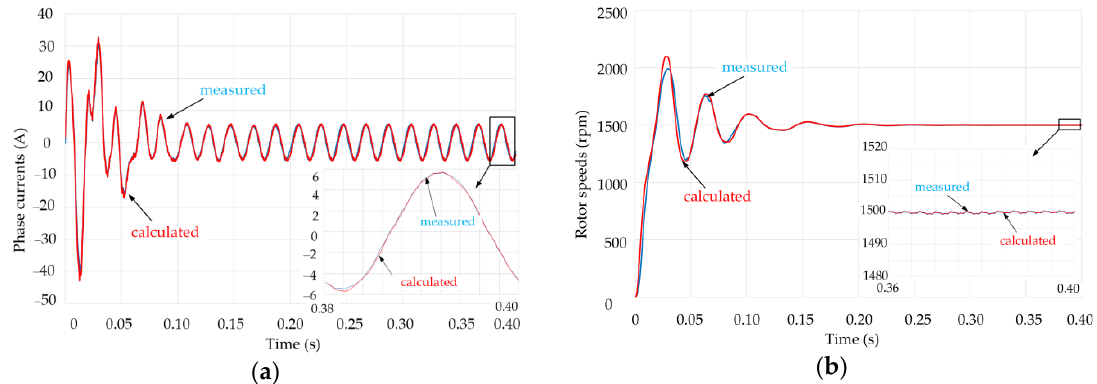
Figure 7. Time curves of ( a ) phase currents and ( b ) rotor speed in τ i = 26°C for T L = 0 Nm, J i = 0.0082 kgm 2 .